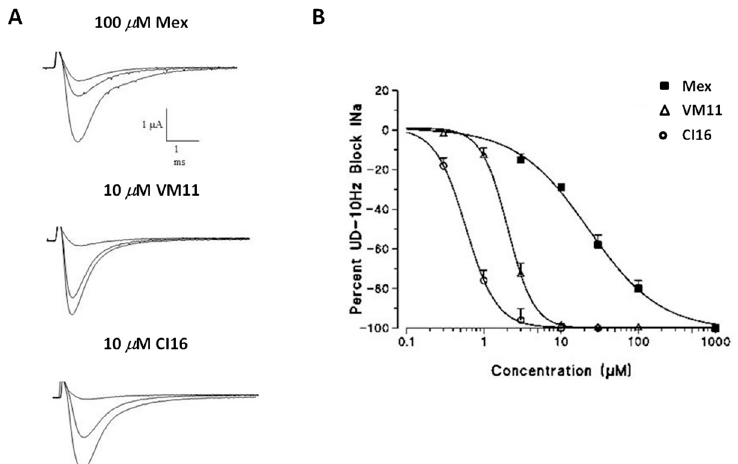
Figure 5. Tonic and use-dependent block exerted by Mex analogues (VM11 and CI16). ( A ) Traces of sodium current transients recorded in the absence and presence of the test compounds 100 μ M Mex, 10 μ M VM11 and 10 μ M CI16. ( B ) Concentration-response curves for 10-Hz use-dependent block of sodium currents obtained with Mex and its tetramethyl-pyrroline derivatives [102].